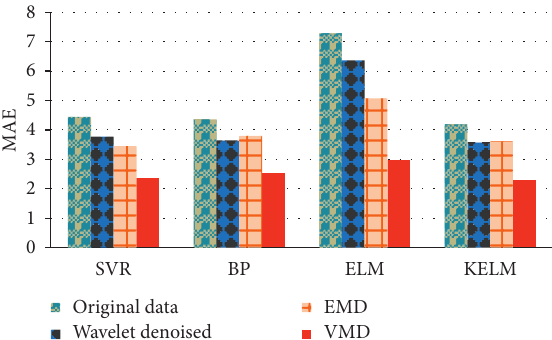
Figure 10: MAE comparison of different approaches.